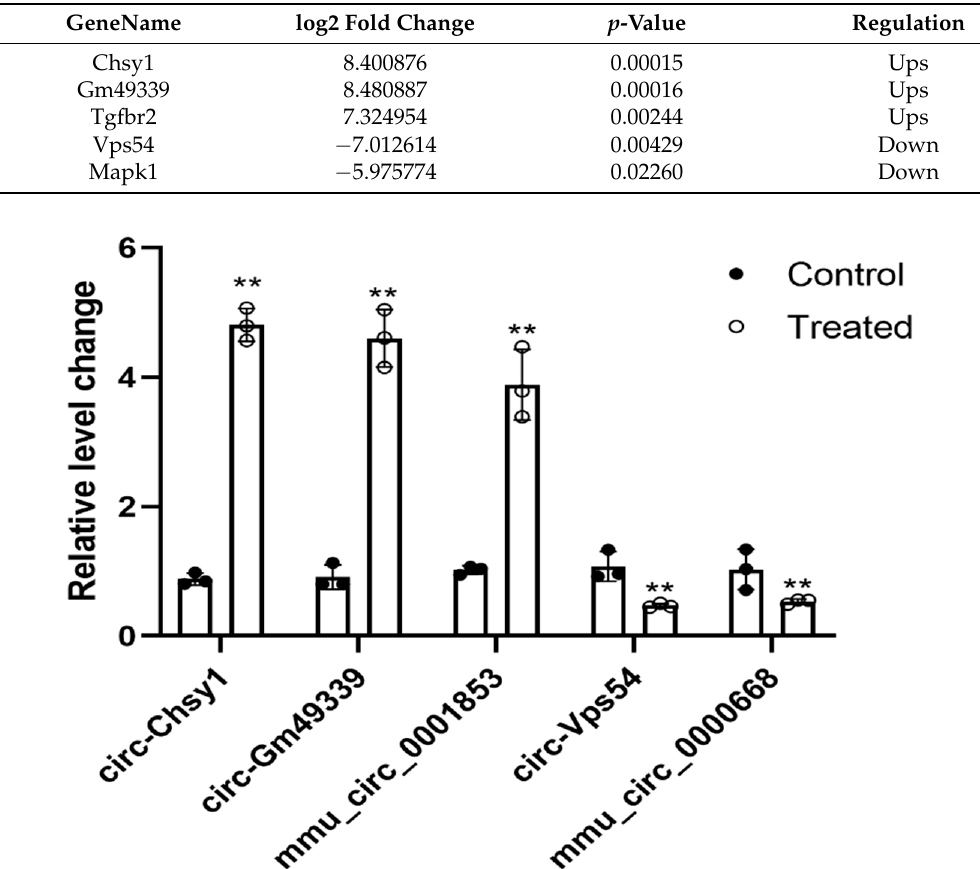
Figure 5. qRT-PCR to verify the expression of five circular RNAs. **, p < 0.01, indicating a significant difference compared with the control group.